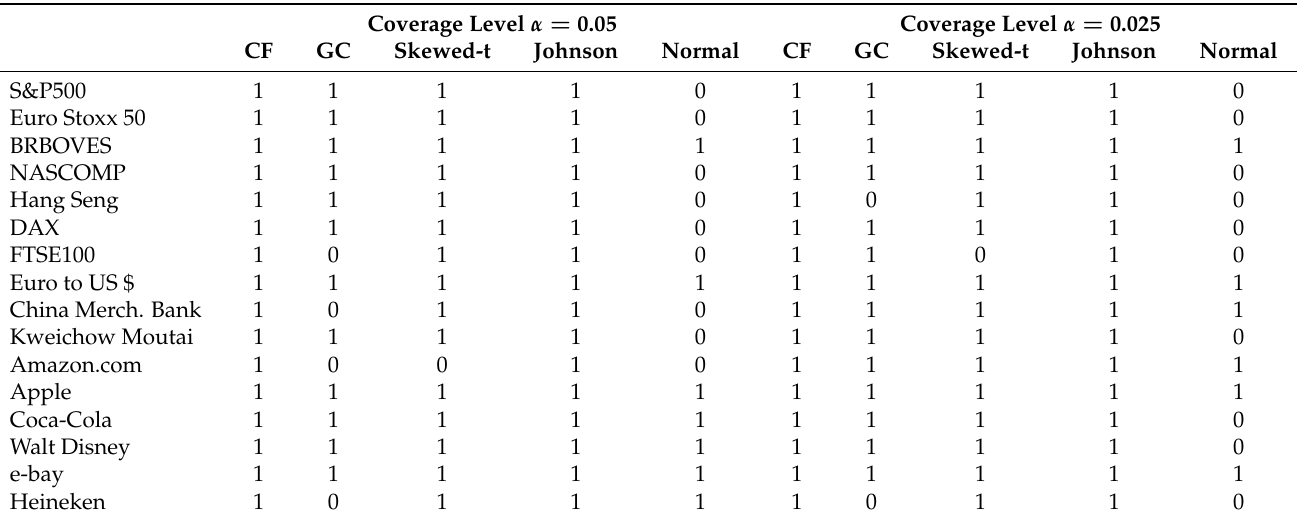
Table 4. Backtesting ES at the 5% Significance